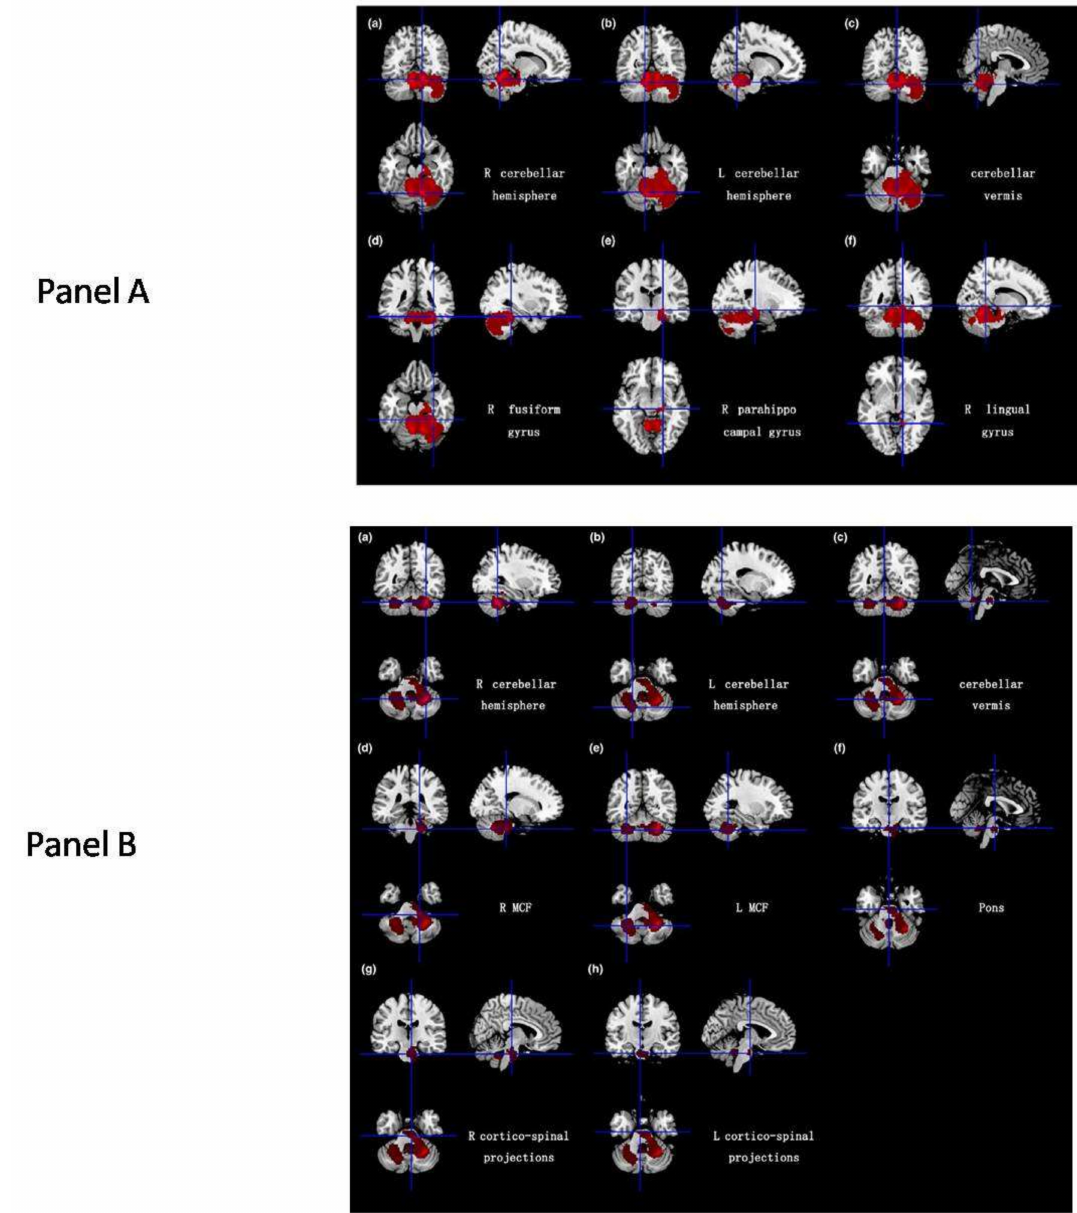
Figure 2. ( A , B ).Results of a meta-analysis of 5 VBM studies in 65 SCA2 gene carriers and 124 healthy controls. Panel A shows atrophy (in red) of the gray matter in bilateral cerebellar hemispheres, cerebellar vermis, the right fusiform gyrus, right parahippocampal gyrus and the right lingual gyrus. Panel B shows the atrophy (in red) of the white matter in bilateral cerebellar hemispheres, cerebellar vermis, middle cerebellar peduncles, pons and bilateral cortico-spinal projections. Reproduced from Han Q, Yang J, Xiong H and Shang H: Voxel-based meta-analysis of gray and white matter volume abnormalities in spinocerebellar ataxia type 2. Brain Behavior 8: e01099,